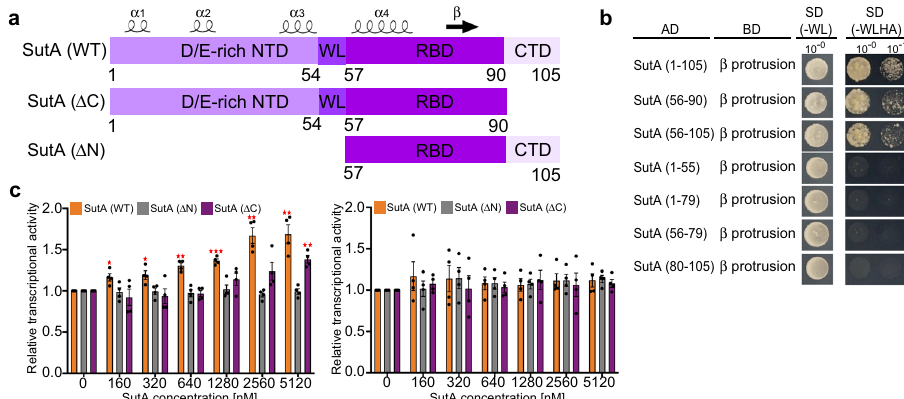
Fig. 1 The requirement of SutA domains in RNAP interaction and transcription activation. a SutA domain scheme annotated with predicted secondary structure features. NTD, N terminal domain; WL, wedge loop; RBD, RNAP-binding domain; CTD, C-terminal domain. b Interaction between the SutA domains and RNAP- β protrusion analyzed by the YTH assay. AD, activation domain of GAL4; BD, DNA-binding domain of GAL4. c SutA activates transcription of the RNAP- σ S holoenzyme (left) but has much less effect on RNAP- σ A holoenzyme (right) in a fl uorescence-based in vitro transcription assay. Truncation of SutA-NTD (SutA ( Δ N)) abolishes the activation activity of SutA. The data were presented as mean±S.E.M., n = 4. The individual data points were shown in black dots. Two-sided Student ’ s t test was performed. * p < 0.05, ** p < 0.01, *** p < 0.001, n = 4. Source data are provided as a Source Data fi le.